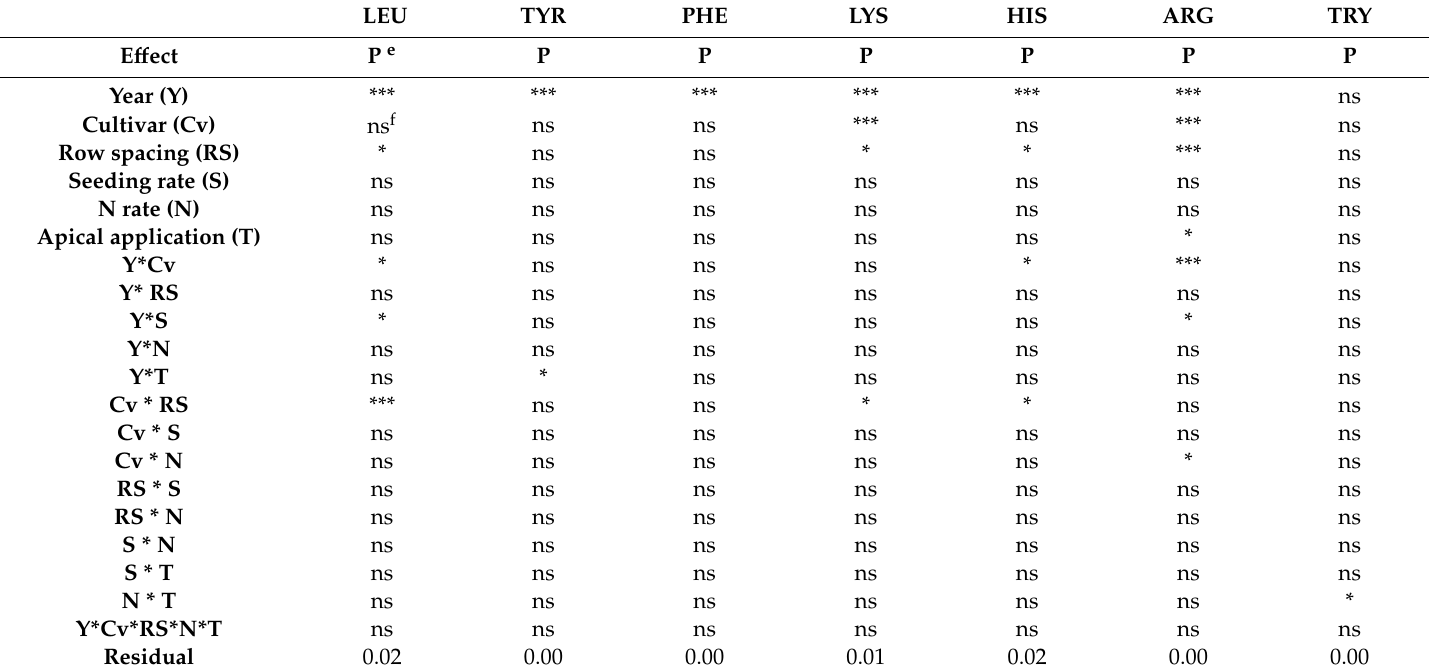
Table 4. Analysis of variance (P values) for the e ff ect of main e ff ects of year (Y), cultivar (Cv), row spacing (RS), seeding rate (S), nitrogen rate (N), apical application (T), and their interactions on seed amino acids leucine (LEU), tyrosine (TYR), phenylalanine (PHE), lysine (LYC), histidine (HIS), arginine (ARG), and tryptophan (TRY) (%). The experiments were conducted in 2015 and